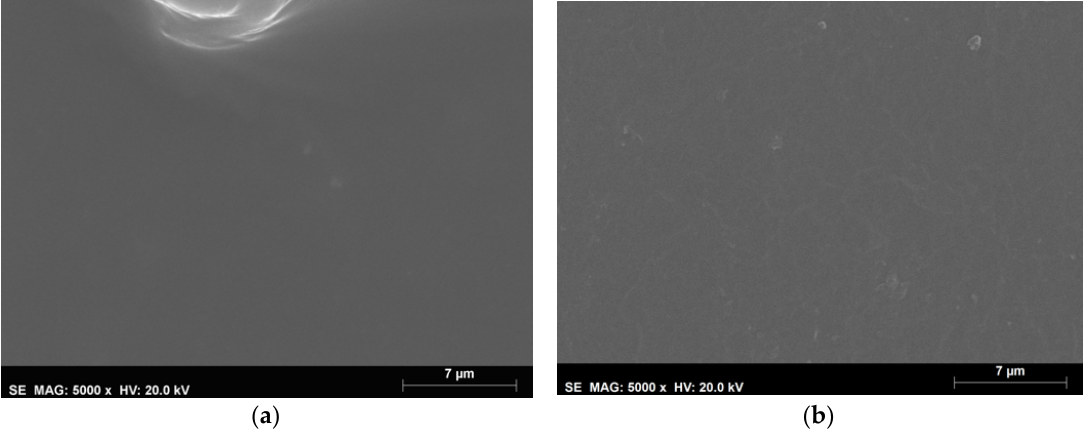
Figure 9. Microstructure of the arabinoxylan films: non enriched ( a ) and enriched with ferulic acid ( b ) obtained with the SEM technique at a magnification of 5000×.